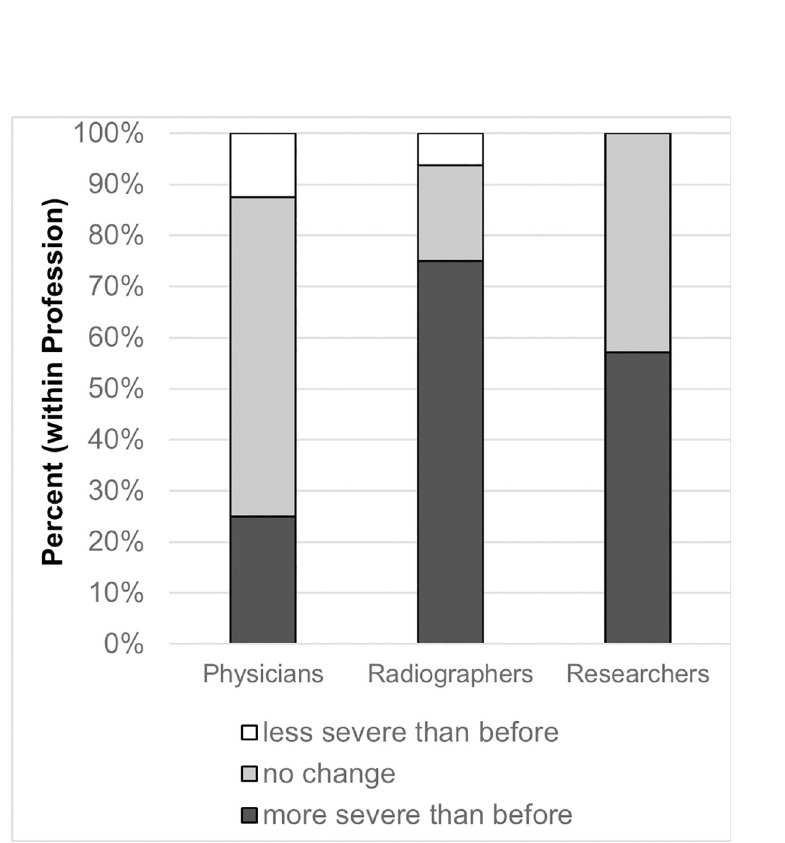
Fig 2. Estimation of stroke-severity after the